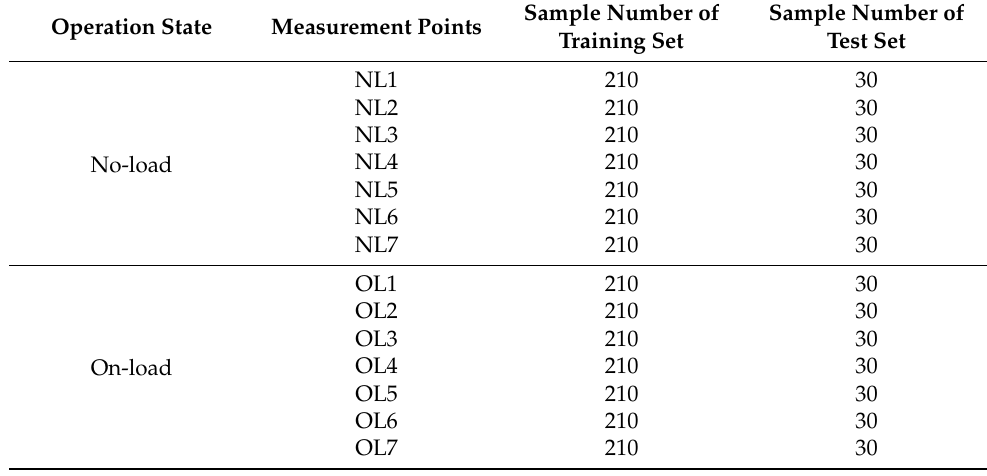
Table 7. Sample description and distribution of vibration signal of converter